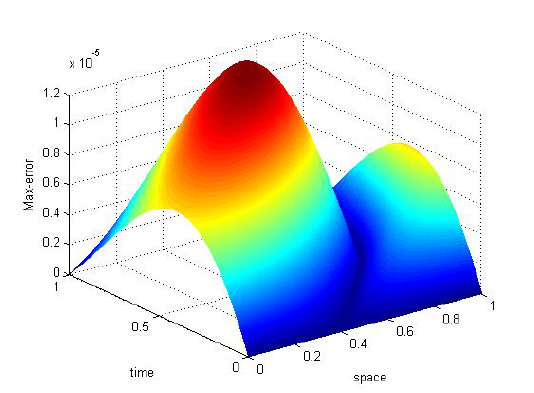
Figure 4. Analytical solution with numerical solution and Max-error are shown for convection -diffusion problem taking k = 0.1, v = 1 gives max − error = 1.1416 × 10 − 5 for numerical example 1.